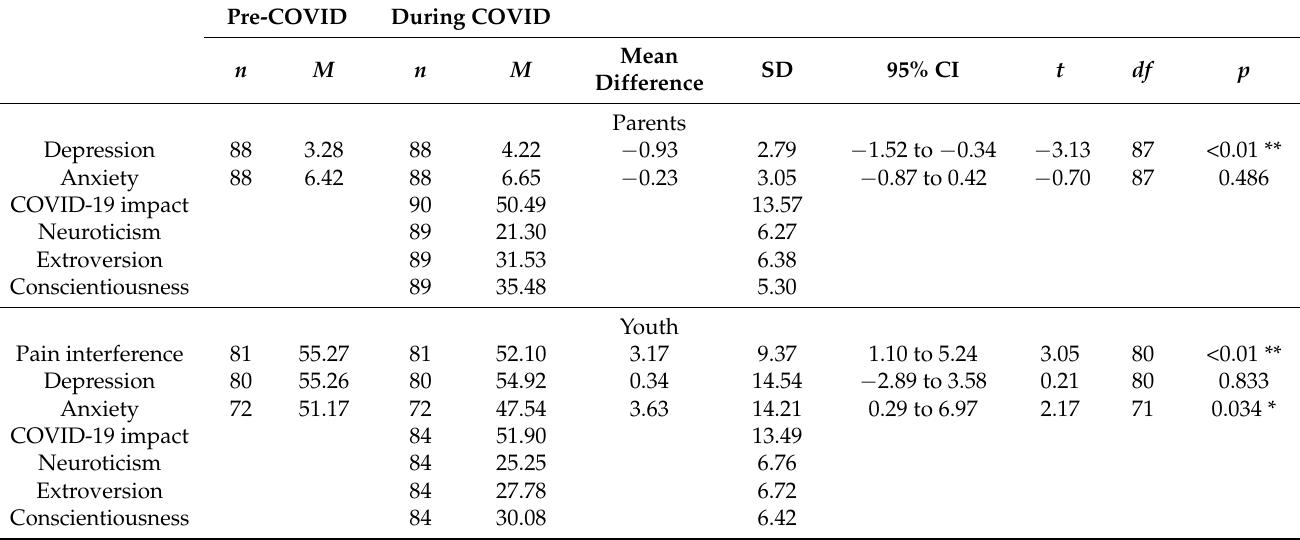
Table 2. Descriptive statistics and change in symptoms from prior to during the COVID-19 pandemic.